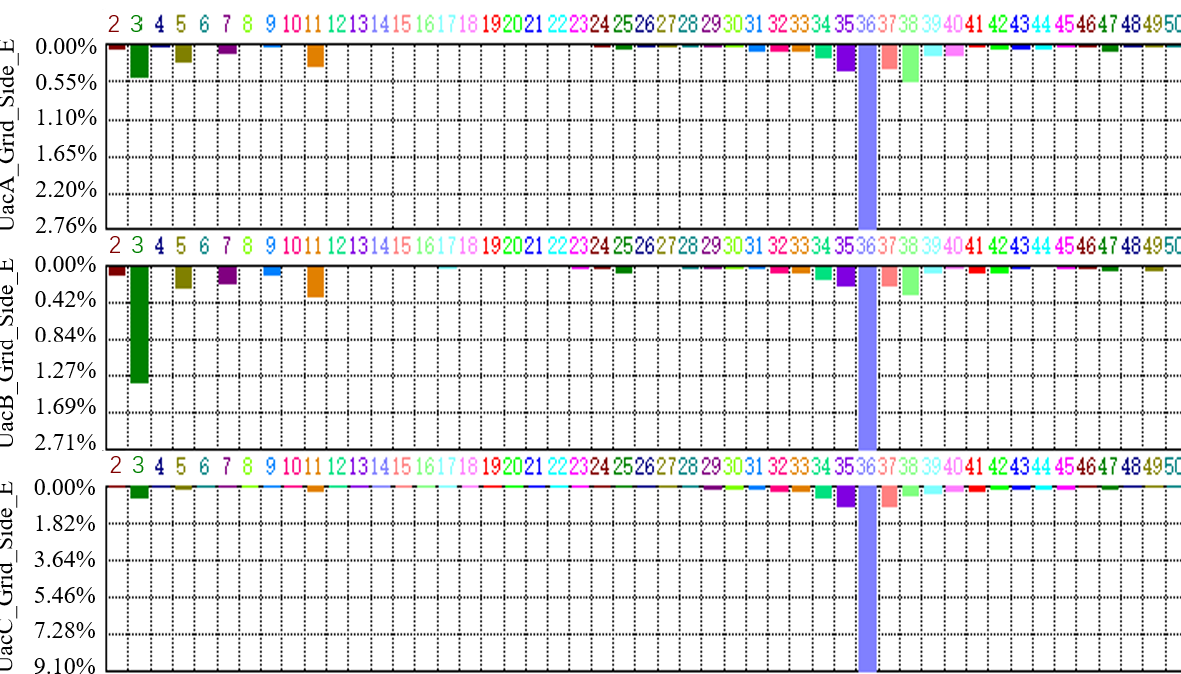
Figure 3. Spectrum analysis of AC voltage.